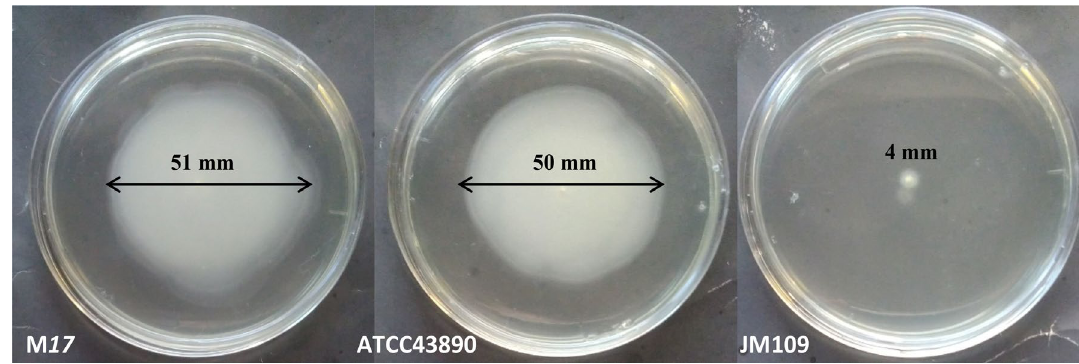
Figure 1. Motility of E. coli strains in a semi-solid